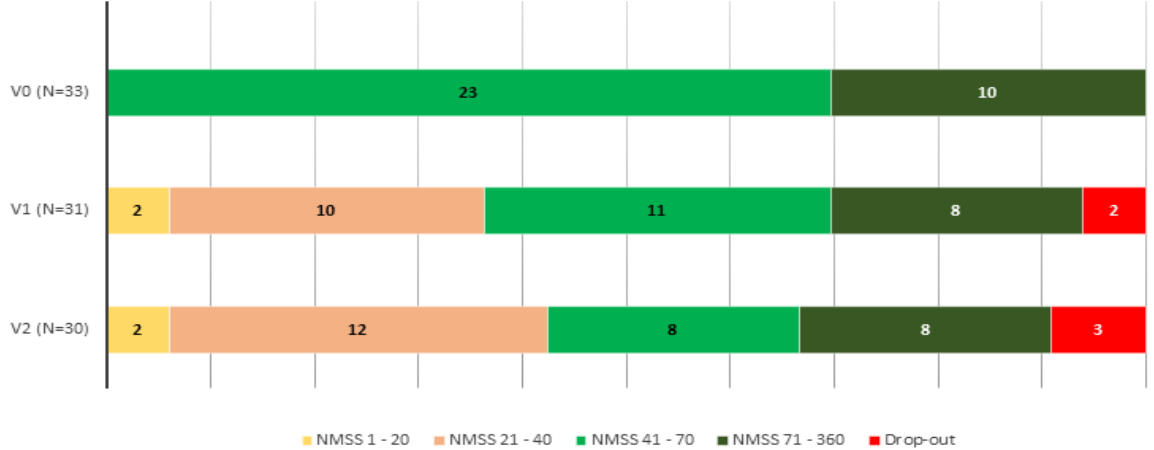
Figure 3. NMS burden with regard to the NMSS total score (0–20, slight burden; 21–40, moderate